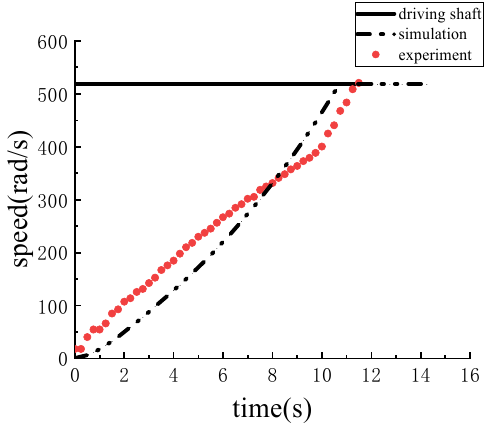
Figure 15. Speed curve for test and simulation.